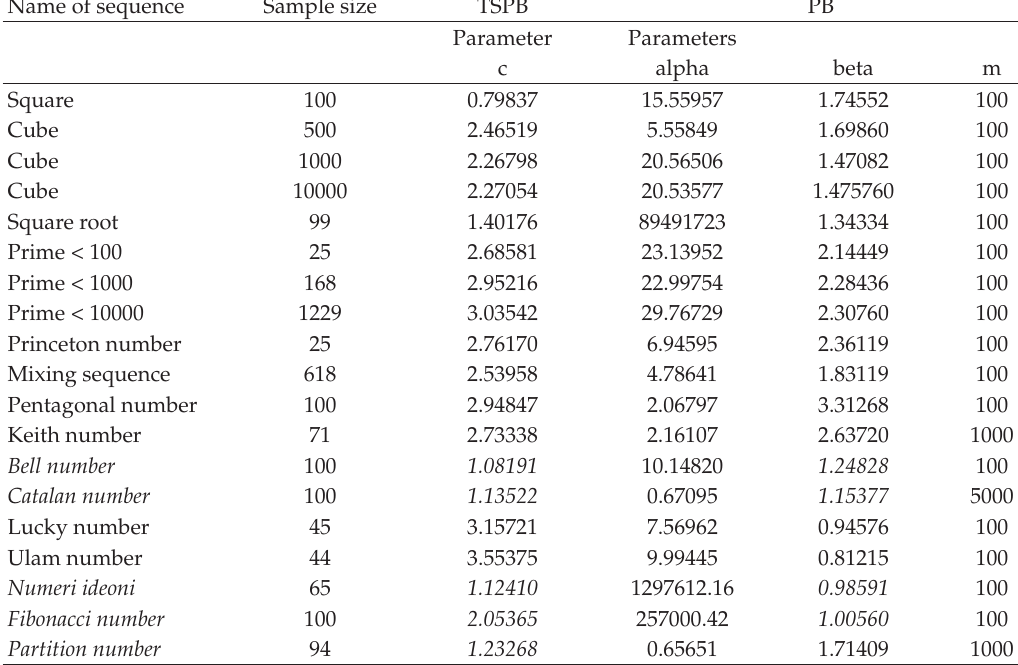
Table 2: Minimum chi-square